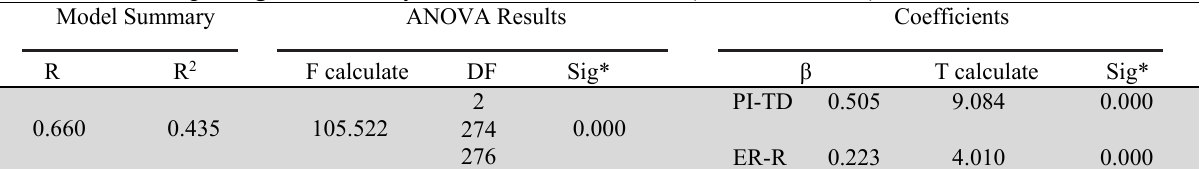
Results of multiple regression analysis for the effect of TM (PI-TD & ER-R) on IO Model Summary